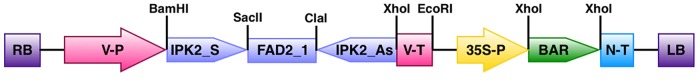
Map showing the T-DNA region of binary vector pCWAK-ipk2. RB: right border; V-P: vicilin promoter; IPK2_S: IPK2 sense fragment; FAD2_1: fatty acid oley1 Δ12 desaturase gene intron; IPK2_AS: IPK2 antisense fragment; V-T: vicilin terminator; 35S-P: cauliflower mosaic virus 35S promoter; BAR: bialaphos resistance gene; N-T: nopaline synthase terminator; LB: left border.